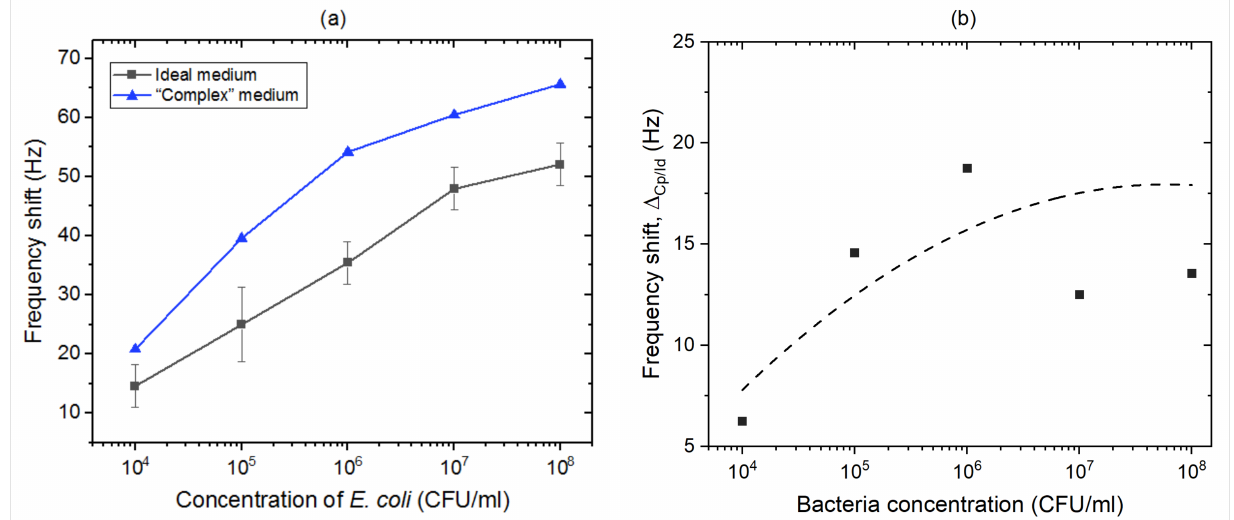
Figure 9. ( a ) Frequency shifts reported for the sensor exposed to increasing concentrations of E. coli in ideal medium (black squares), and E. coli in “complex” medium (blue triangles). ( b ) Difference between frequency shifts determined for E. coli in “complex” and ideal media (broken line is shown as a guide to the